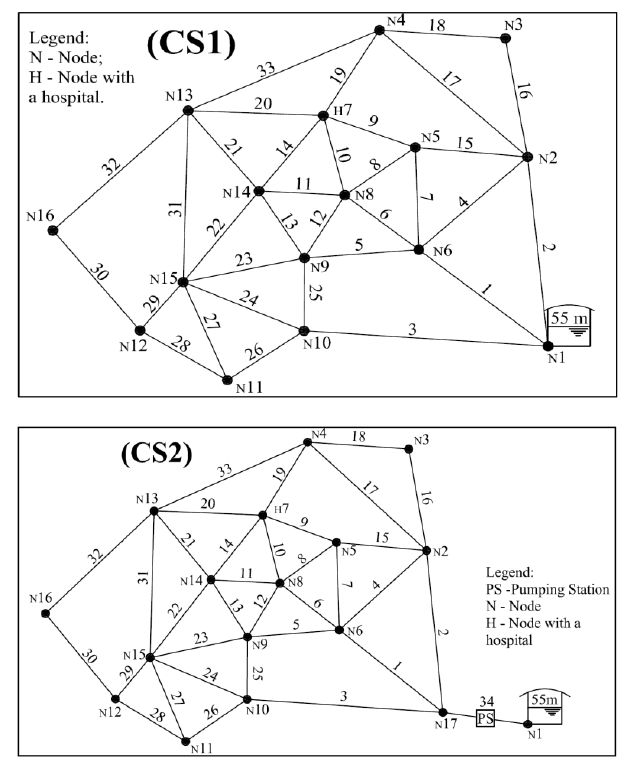
Figure 1. Network schemes: case study 1 (CS1) and case study 2 (CS2).